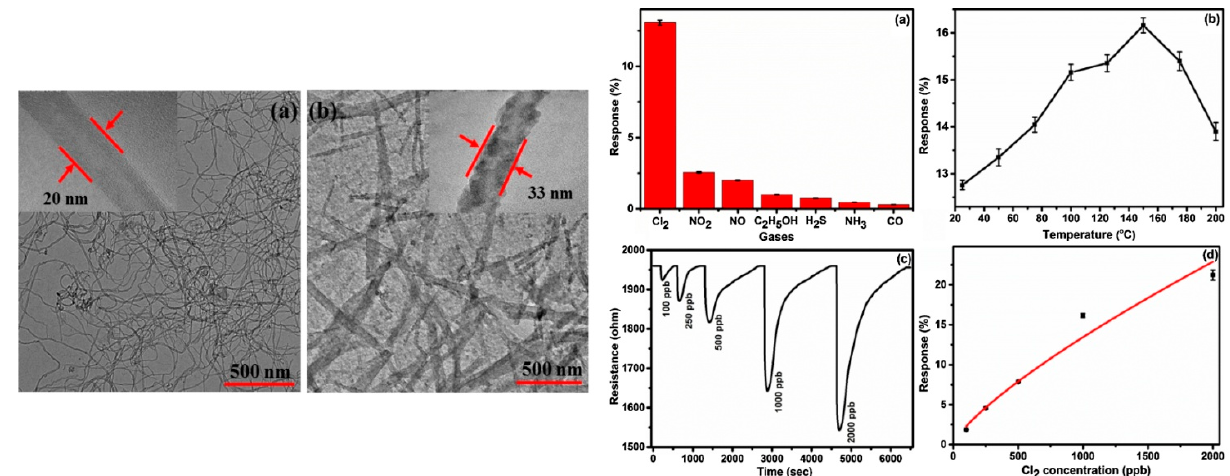
Figure 11. ( left ) TEM images of MWCNTs-COOH ( a ) and ZnPcF 16 /MWCNTs-COOH ( b ) hybrids. ( right ) ( a ) Response histogram of a ZnPcF 16 /MWCNTs-COOH sensor for 1 ppm of Cl 2 , NO 2 , NO, C 2 H 5 OH, H 2 S, NH 3 and CO at room temperature; ( b ) Sensor response as a function of temperature for 1 ppm of Cl 2 concentration; ( c ) Response curves of the sensor for different doses of Cl 2 at 150 °C; ( d ) Variation in the response of sensor with Cl 2 concentration. Reprinted from [64] with permission from Elsevier.